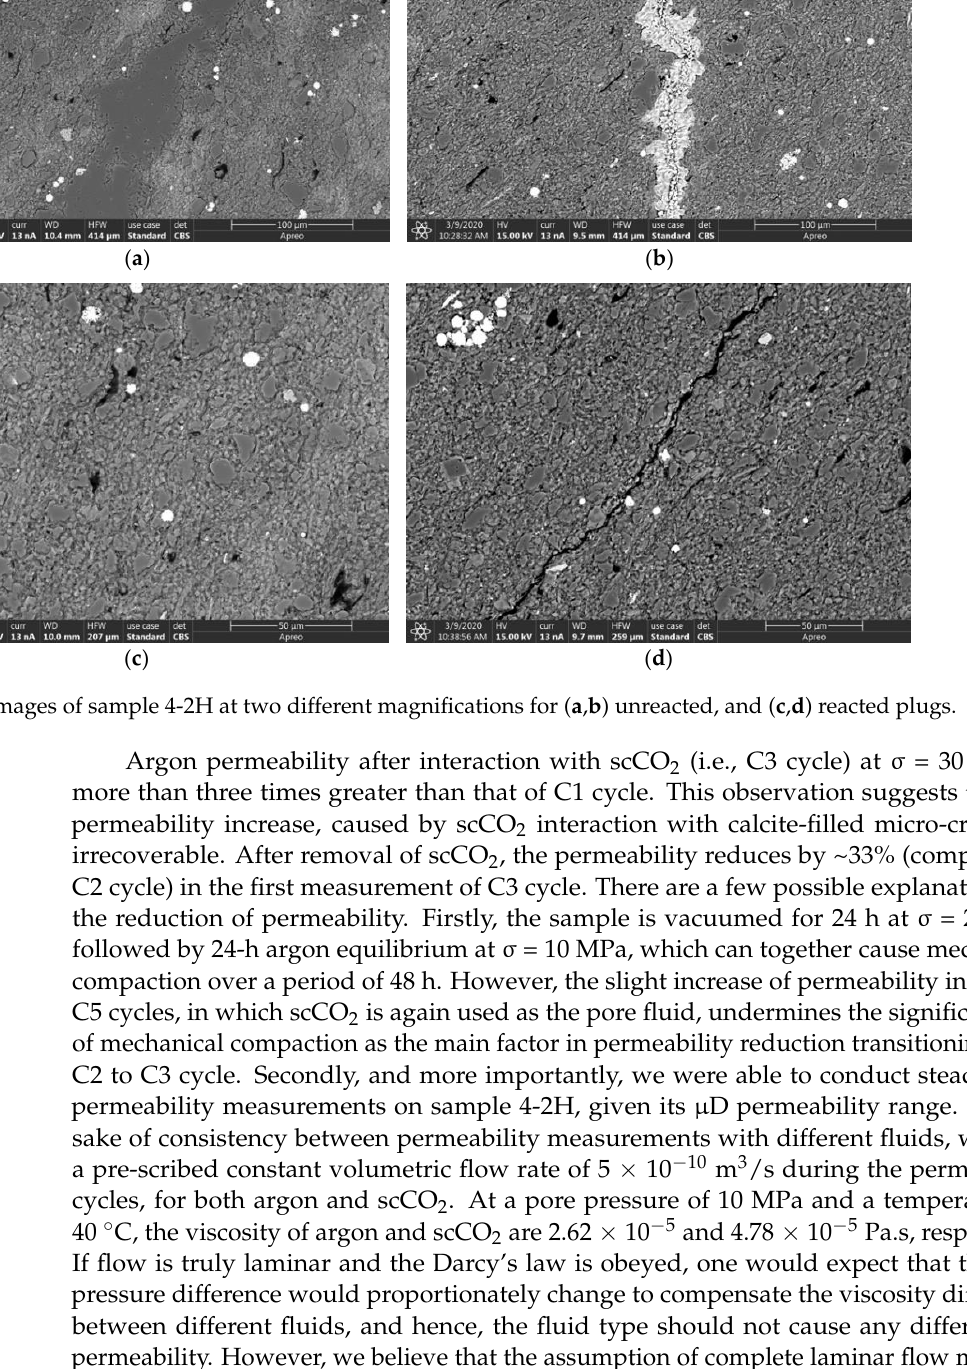
Figure 5. Permeability changes for sample 4-2H.